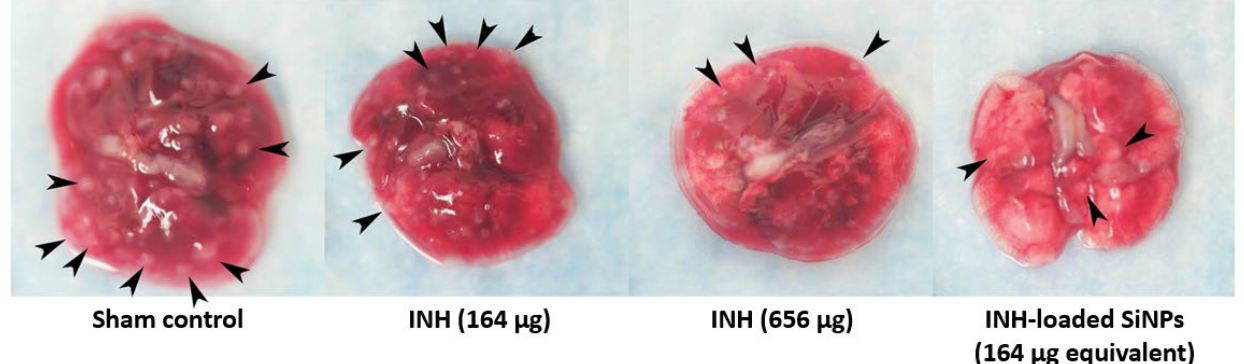
Figure 10. Lung tissues from untreated mice, from mice treated with free isoniazid (INH), and from mice treated with INH-loaded mesoporous silica nanoparticles (SiNPs) administered intravenously or subcutaneously. Black arrows indicate granulomas visible to the naked eye. Adapted from reference [118], copyright (2022) by Copyright Clearance Center, with permission from John Wiley and Sons.